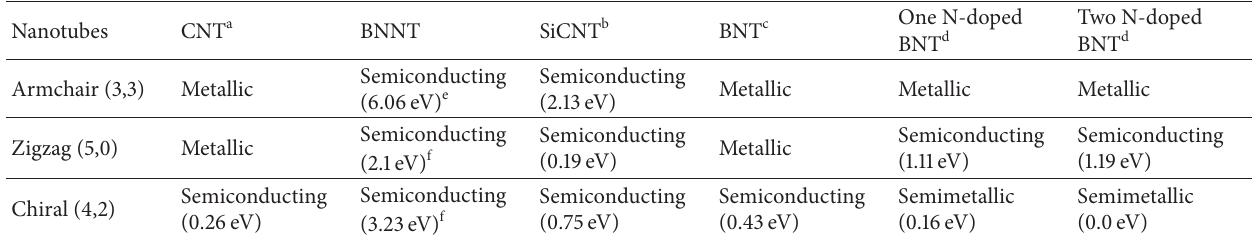
Table 1: Comparison of electronic properties of various nanotubes.